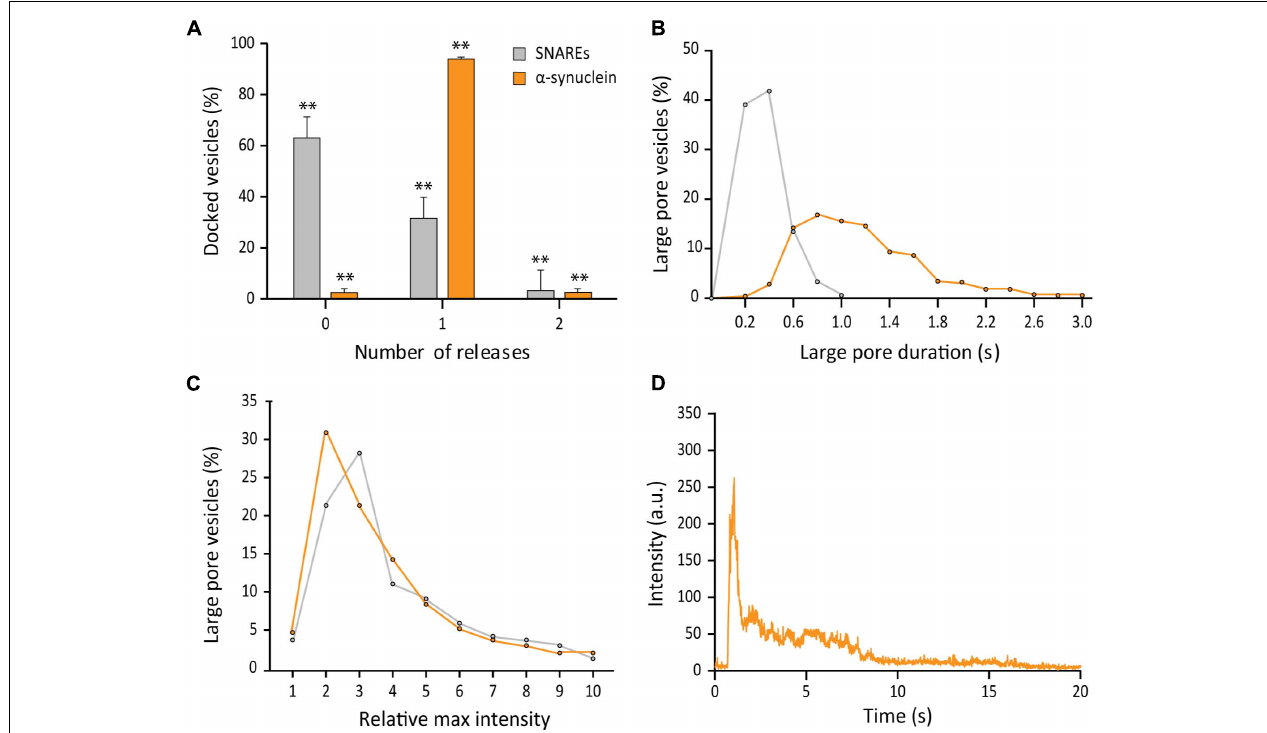
FIGURE 4 | α S promotes probability, duration, but not the size of the large fusion pore. (A) Distribution of number of large pore fusion events for individual docked vesicles. For α S, events from 7 independent measurements were analyzed for A–C . Error bars represent standard deviations from means. The data are shown as means ± SD. ∗∗ p < 0.01 by Student’s t -test; n = 3 independent experiments. (B) Distribution of the duration of the large fusion pore. (C) Distribution of relative maximum intensities of large pore fusion events. (D) Representative fluorescence time trace of a large pore fusion event with α S.